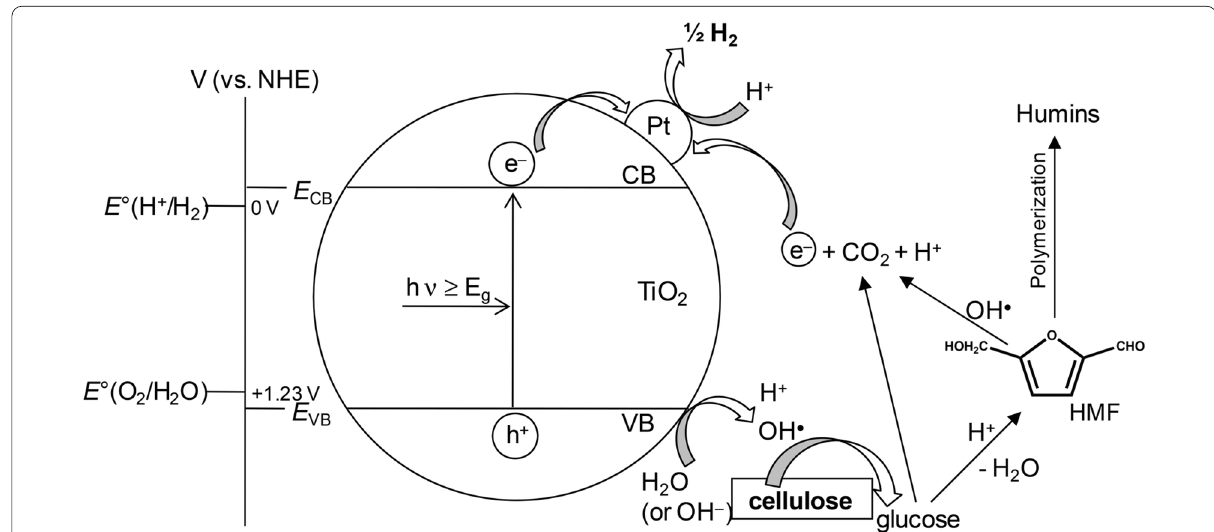
Fig. 2 Schematic illustration of the photocatalytic H 2 evolution using Pt/TiO 2 in the presence of cellulose. Reprinted with permission from Speltini et al. [17] (Copyright 2014 Royal Society Chemistry (RSC). Published by the RSC on behalf of the European Society for Photobiology, the European Photochemistry Association, and